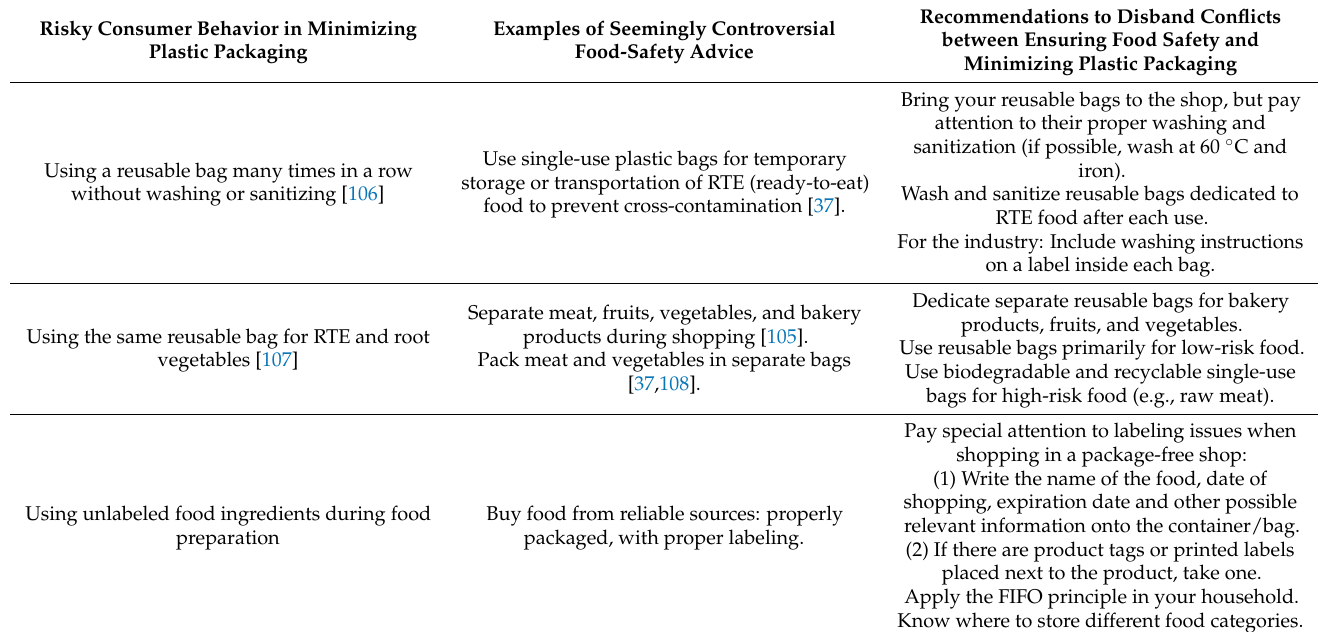
Table 2. Messages targeting risky behaviors from the domain of sustainability–safety controversy regarding the minimizing of plastic